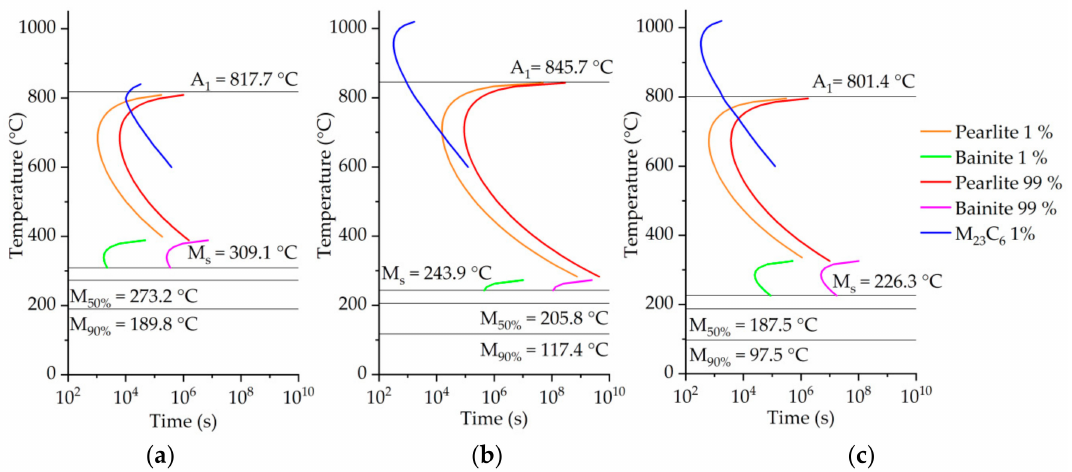
Figure 7. Thermophysically calculated isothermal phase transformation diagrams (TTT) and M23C6 precipitations of the materials ( a ) X12Cr13, ( b ) X30Cr13 and ( c ) X46Cr13 after austenitization at 1050 ◦ C and ASTM grain size = 9 using JMatPro ®